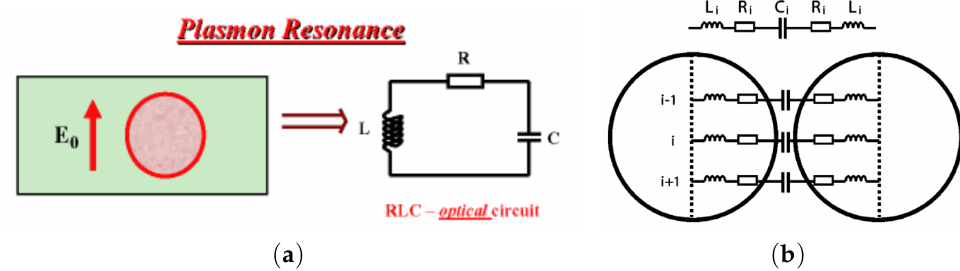
Figure 1. ( a ) L-C-R contour mapping of a plasmonic nanoparticle resonance. Plasmonic nanoparticle is represented by the Inductance (L) and resistance (R), and the surrounding medium by the capacitor (C); ( b ) plasmonic response depending on the frequency described as an L-C-R circuit array, reprinted with permission from [45], Copyright 2004 American Chemical Society, and from [76], Copyright 2007 World Scientific Publishing Co. Pte.